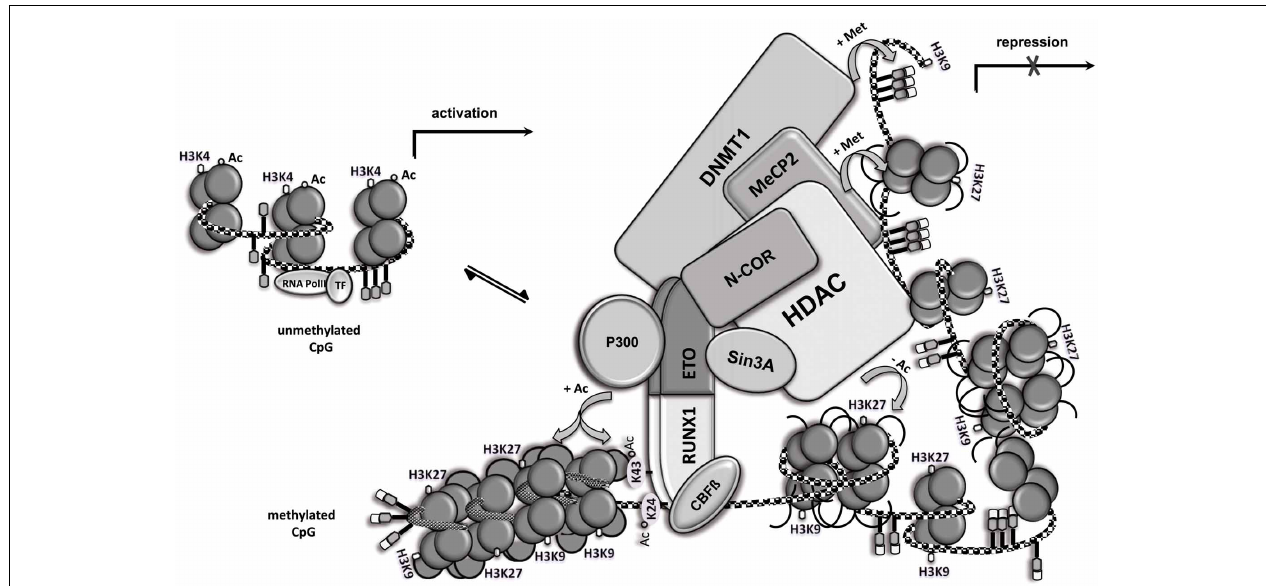
FIGURE 2 | RUNX1/ETO assembles multiple epigenetic regulators. Open chromatin (left side) and chromatin modification following RUNX1/ETO DNA-binding and high molecular weight complex formation. RUNX1/ETO recruits several proteins, including N-CoR, mSIN3A, HDAC, MeCP2 and DNMT1, into a high molecular weight complex that triggers